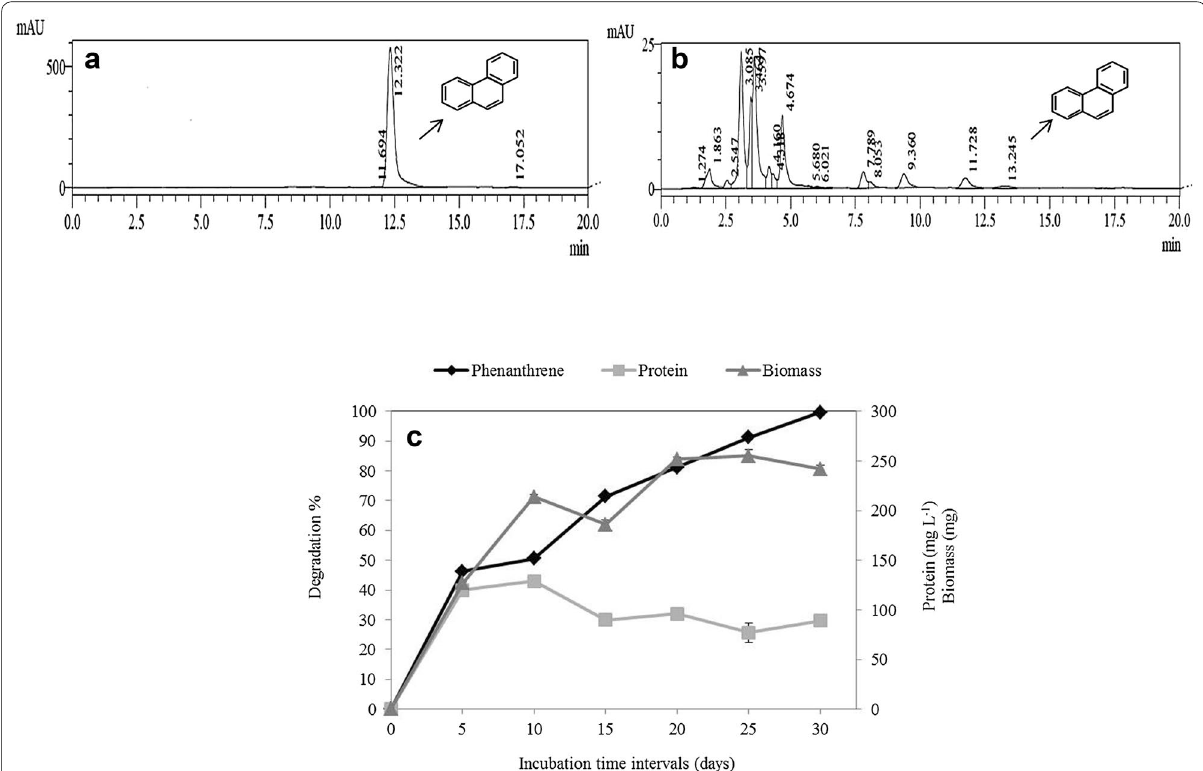
Fig. 2 Degradation analysis of phenanthrene by fungal strain CCG1. HPLC chromatogram of phenanthrene before ( a ) and after ( b ) treatment by strain CCG1. c Degradation of phenanthrene and production of biomass, protein by